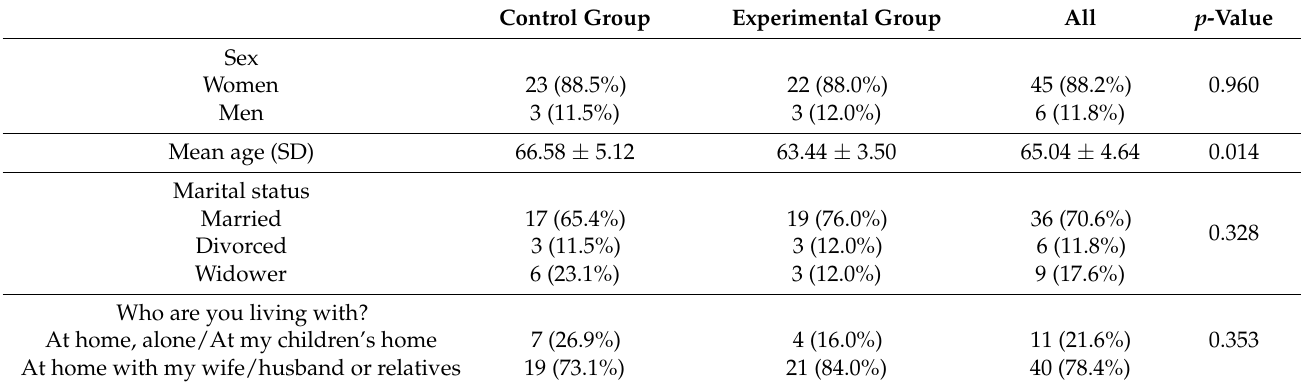
Table 1. Sociodemographic and lifestyle variables. SD, standard